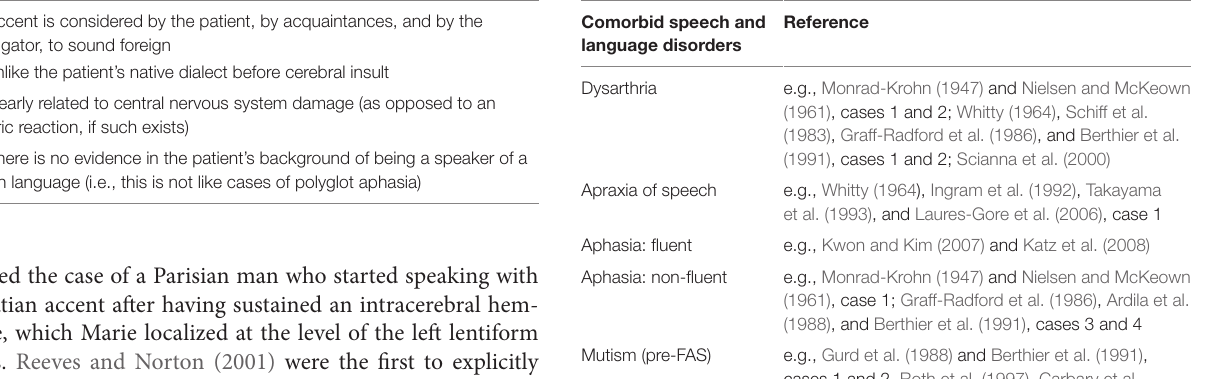
taBLe 1 | Whitaker’s operational definition of Fas (Whitaker, 1982; pp. 196 and